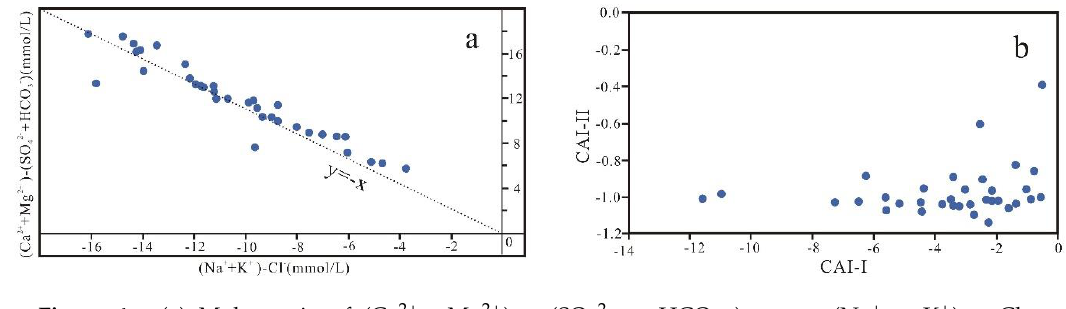
Figure 4. ( a ) Molar ratio of (Ca 2+ + Mg 2+ ) − (SO 4 2− + HCO 3 − ) versus (Na + + K + ) − Cl − ; ( b ) chloro-alkaline